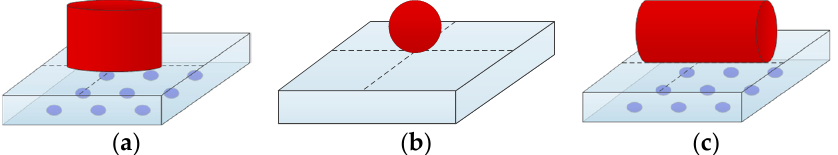
Figure 5. Contact state diagram of the three different surface types: ( a ) plane; ( b ) convex spheres; ( c ) convex cylinder.